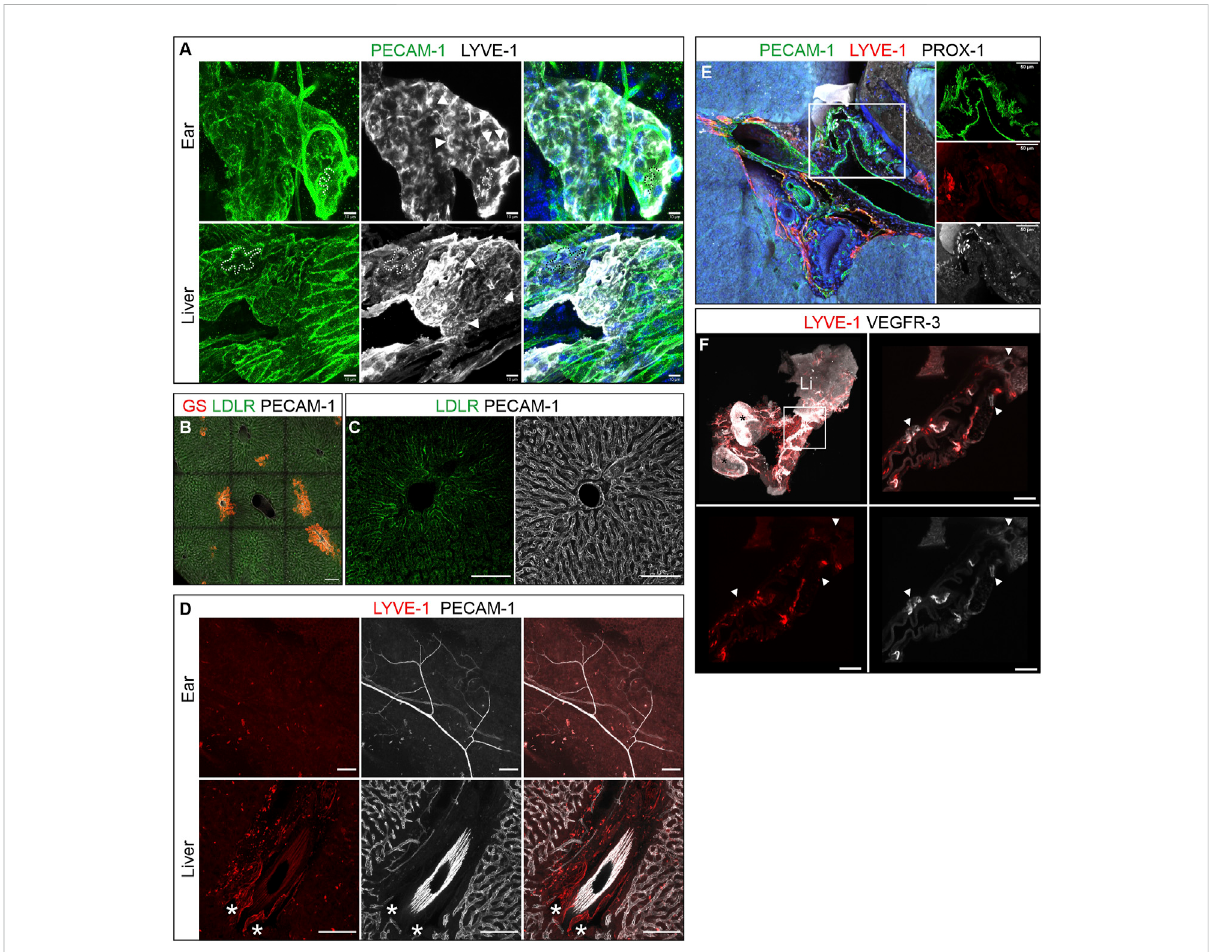
FIGURE 4 Lymph fl ow in the murine liver. (A) Hepatic lymph vessels were composed of capillary lymphatic endothelial cells (LECs). Like LYVE-1 positive dermallymphcapillaries(toprow),hepaticLECsdisplayedtheprototypicoak-leaveshapeofcapillary(cap)LECsandformedblindendingspikeswith a highly irregular wide lumen. Dashed lines outline the cell border of one exemplary LEC in each sample. Arrowheads indicate LYVE-1 positive primary valves of capLECs. Scale bar = 10 µm. (B – D) : Hepatic blood and lymph fl ow tracking via PVI of anti-PECAM-1, anti-LDLR and/or anti- LYVE-1 antibodies.Scalebar=100 µm. (B) :GSimmunostainingidenti fi edzone3sinusoidsandcentralveins. (C) LDLRimmunereactivity waslimited tozone1-sinusoids(absenceofGS-staining),whilePECAM-1stainingwashomogenous (D) :AsterisksindicateLYVE-1-positivelymphaticsintheliver after PVI, while no lymphatic vessels were identi fi ed in a whole mount preparation of the ear. (E) : Immunostaining (vibratome section of the right lobe, 300 µm) of a large portal tract near the porta. LYVE-1-neative, but PROX-1-positive collecting lymph vessels were identi fi ed in the region surrounded by the rectangle (details in panels on the right side). Scale bar = 50 µm. (F) : 3D reconstruction of a whole mount stained portal vein connected to the liver (Li) and two attached lymph nodes (asterisks). Note the lymph vessels wrapping around the large vein. Magni fi cations of